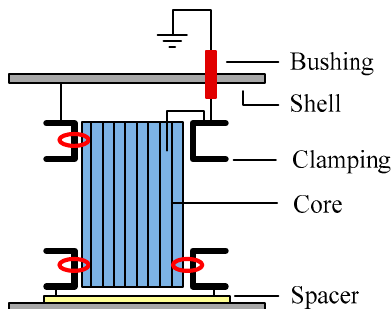
Figure 2. Artificial PD models. ( a ) Cavity discharge; ( b ) Surface discharge; ( c ) PD due to bad grounding; ( d ) PD due to floating particles; ( e ) PD in air bubble dissolved in oil; ( f ) PD caused by metal protrusions.